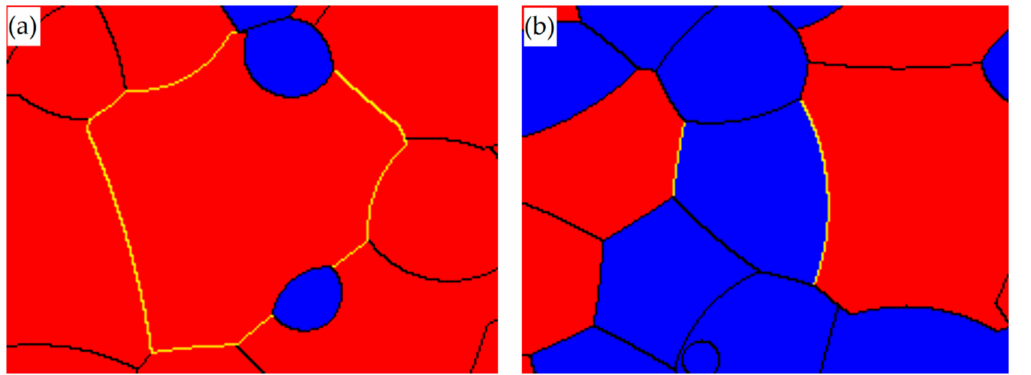
Figure 2. The spruce contribution to individual tree competition ( C sp ) is the proportion of the boundary of the area potentially available ( APA ) of the subject tree which is bordered by spruce. ( a ): A spruce (red) surrounded by seven other spruces and three larches, the proportion of the boundary to spruce (yellow lines) to the total boundary is C sp = 0.748. ( b ): A larch (blue) surrounded by three other larches and two spruces, the proportion of the boundary to spruce (yellow lines) to the total boundary is C sp =